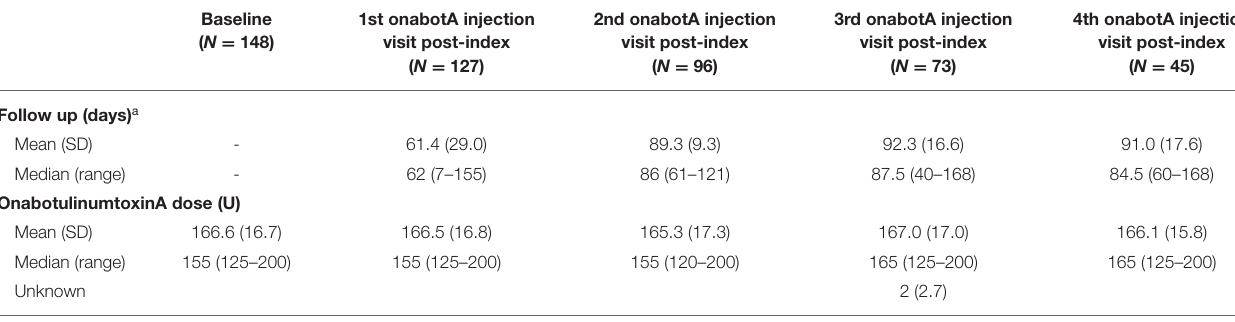
TABLE 2 | OnabotulinumtoxinA dosage during baseline and combination treatment.